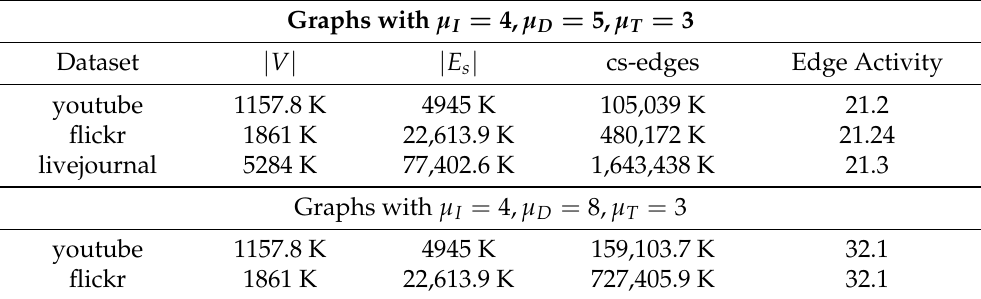
Table 2. Synthetic graphs statistics.